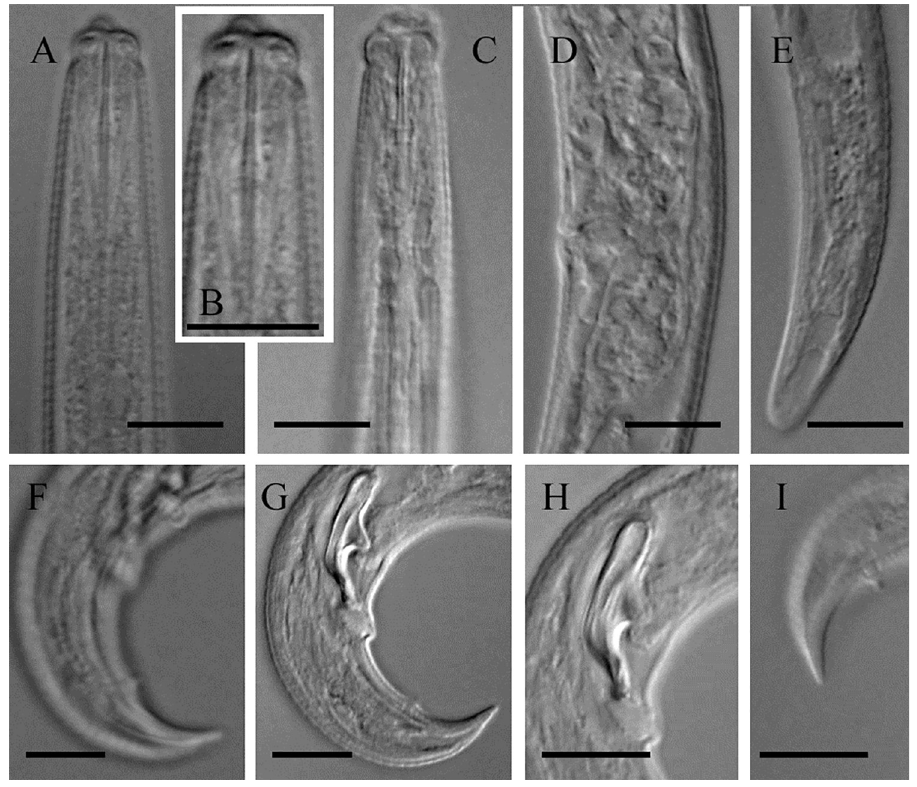
Fig 3. Iranian population of Devibursaphelenchus teratospicularis Kakulia & Devdariani, 1965 [13]. A-C: Anterior region of body (B: Stylet in higher magnitude), D: Vulva region and postvulval uterine sac (PUS), E: Female posterior body end, F&G: Male posterior body end, H: Spicules, I: Bursa in lateral view. (All scale bars = 10 μ